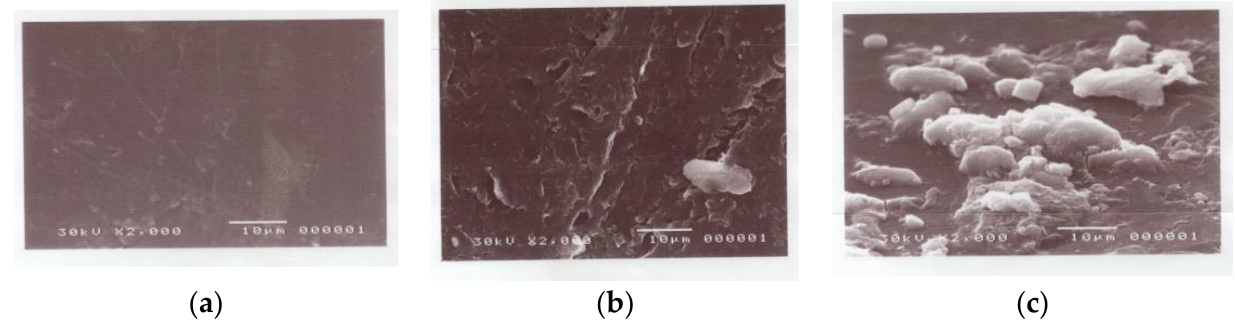
Figure 10. Scanning electron micrographs of the PP membranes before and after grafting. ( a ) PP blank, ( b ) the PP-grafted membrane, and ( c ) the PP amidoximated membrane.